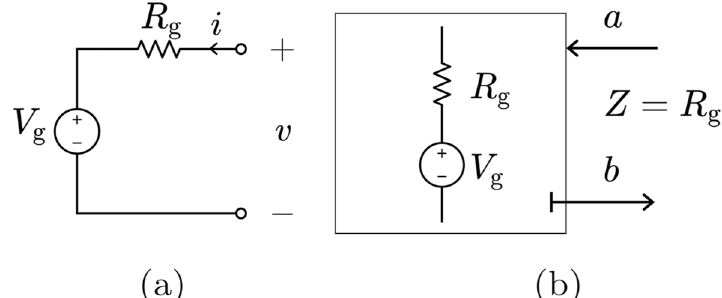
Fig. 1 Generic linear one-port element a in the Kirchhoff domain and b in the wave digital domain. The T-shaped stub indicates port